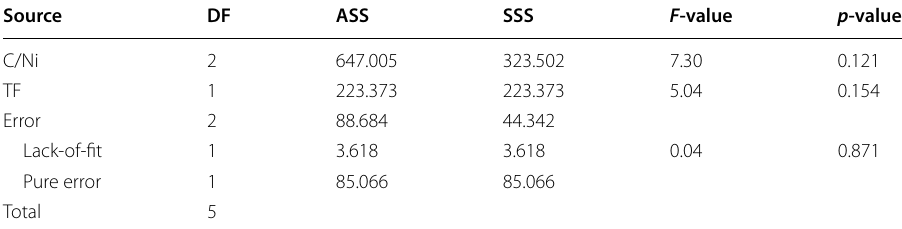
Table 14 ANOVA test associated with C/Ni and TF effects on CEC Source